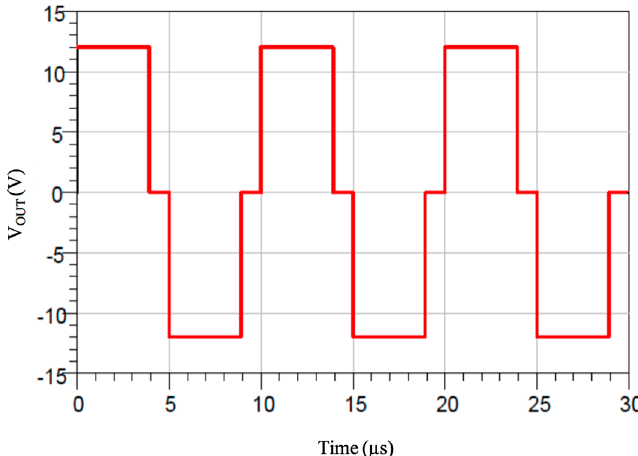
Figure 7. Modified square wave used to drive the H-Bridge.